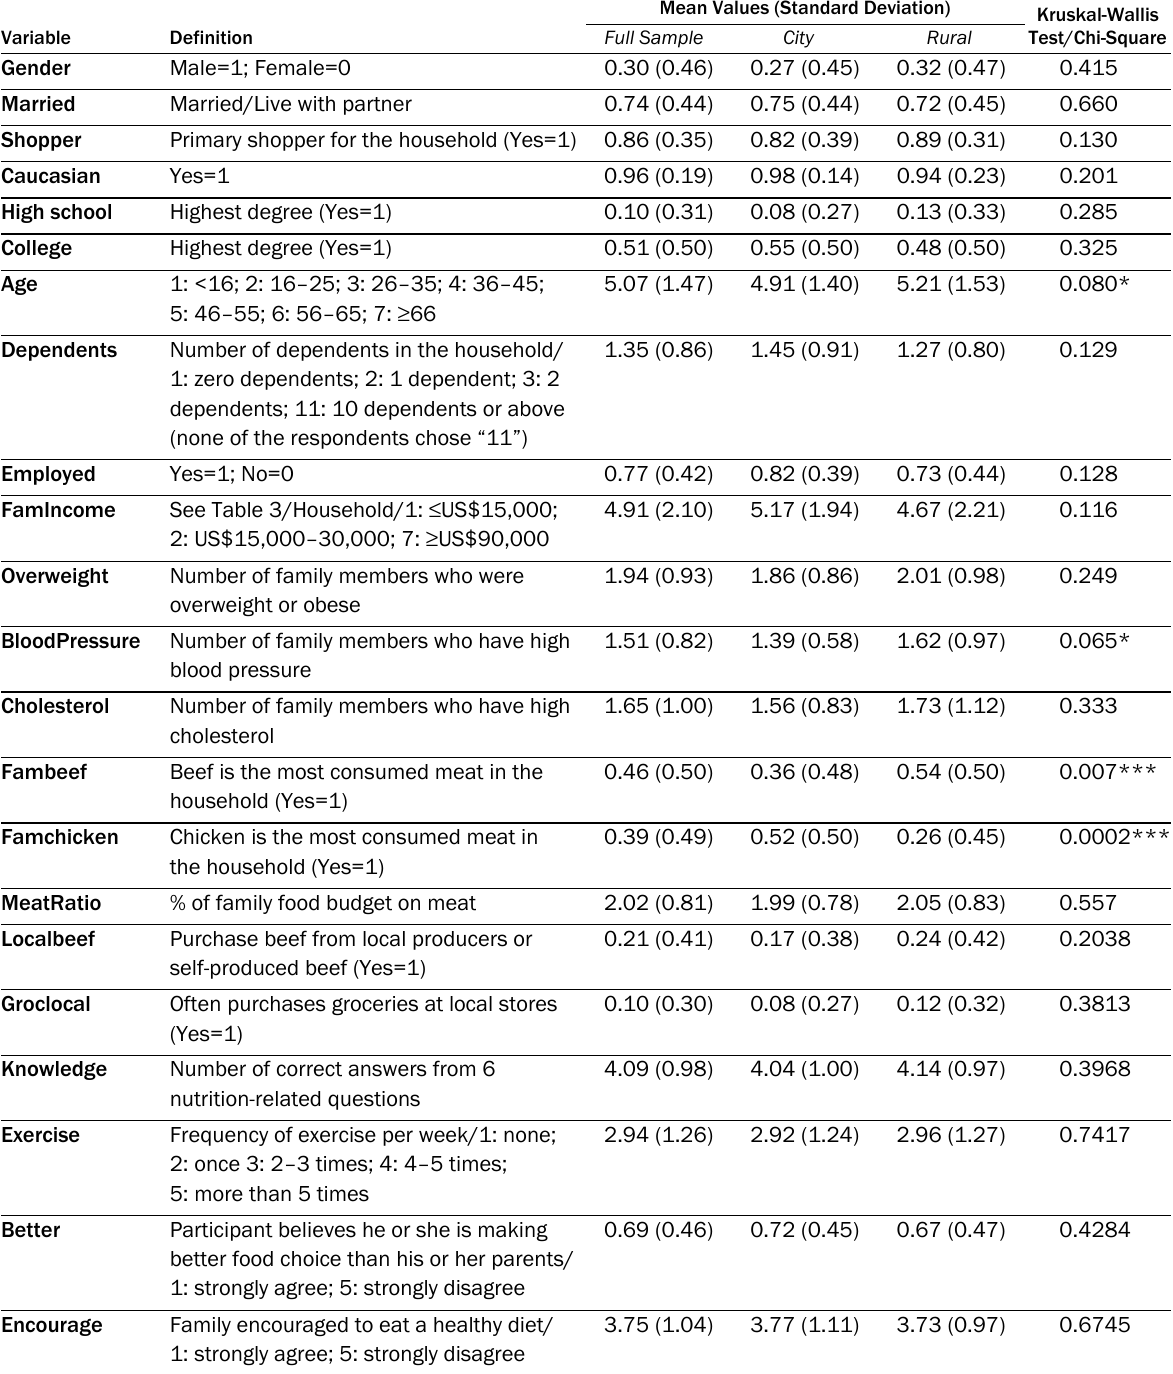
Table 3. Variable Definition and Means of Consumer